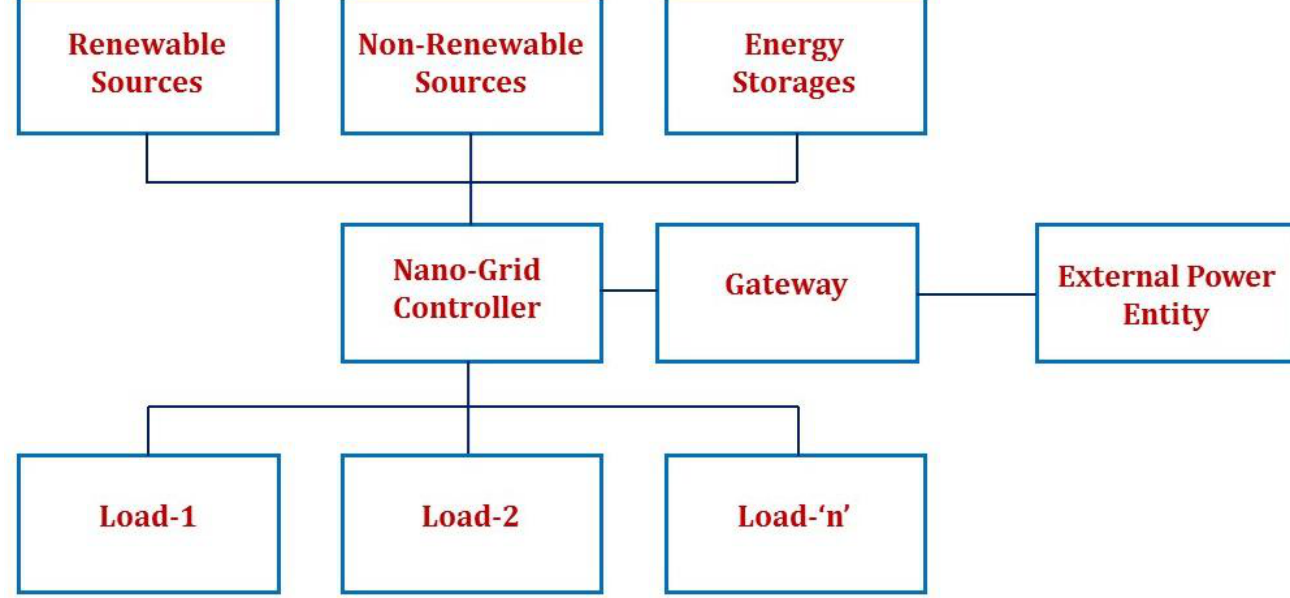
Fig. 1. Block diagram of proposed